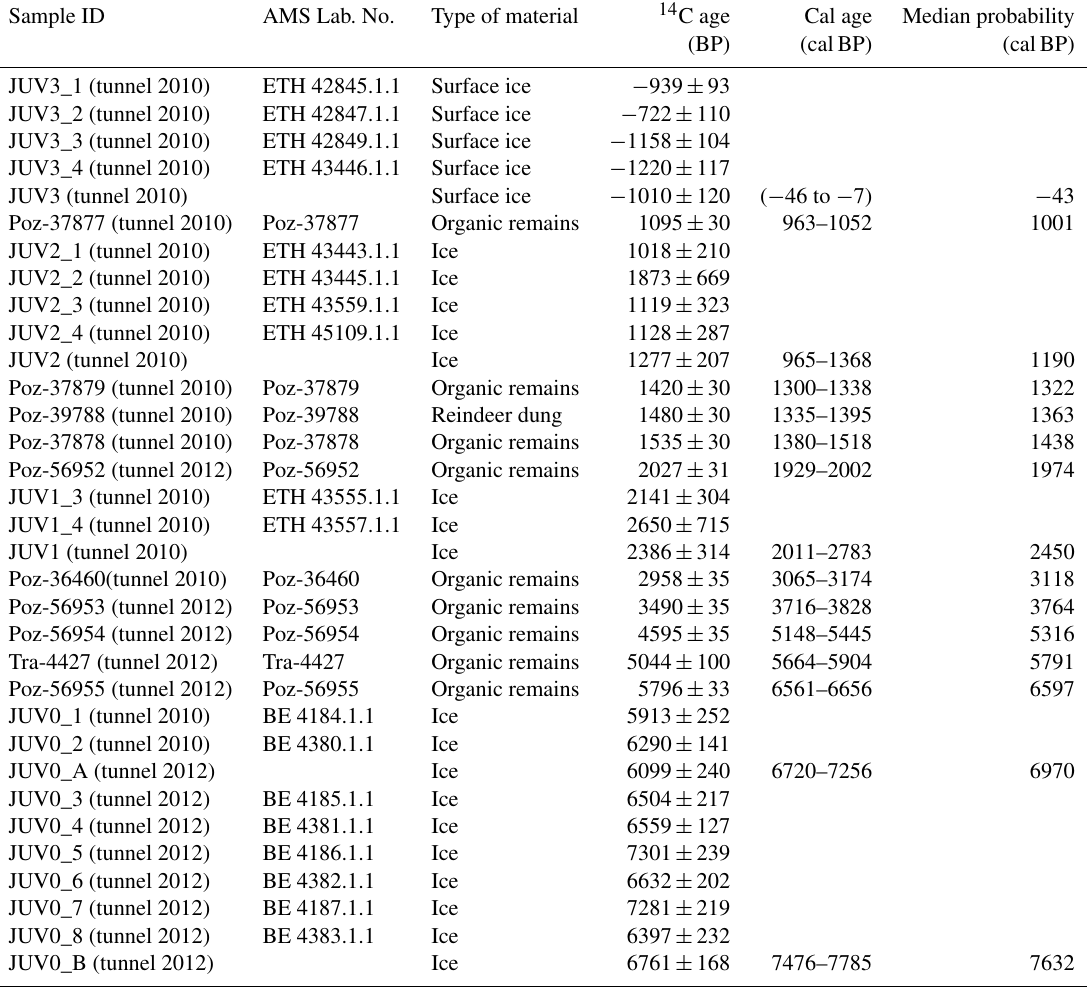
Table 2. AMS radiocarbon dates from the ice tunnels (clear ice samples and organic remains) and ice samples from the ice patch surface. Ice samples collected as blocks and subdivided in several sub-samples. Therefore, an average value is shown for every block (JUV1, JUV2 and JUV3), except for JUV0 because JUV0_1 and JUV0_2 were taken adjacent to the plant fragment layer, dated 6600calBP (Poz-56955), while samples from JUV0_3 to JUV0_8 were collected at the bottom of the wall, a few centimetres below the plant fragment layer. Thus, JUV0_A is the yielded average of JUV0_1 and JUV0_2, while the other six samples were averaged as JUV0_B. Calibrated ages (calBP) denote the 1 σ